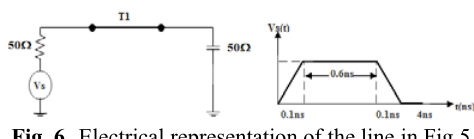
Fig. 6. Electrical representation of the line in Fig.5